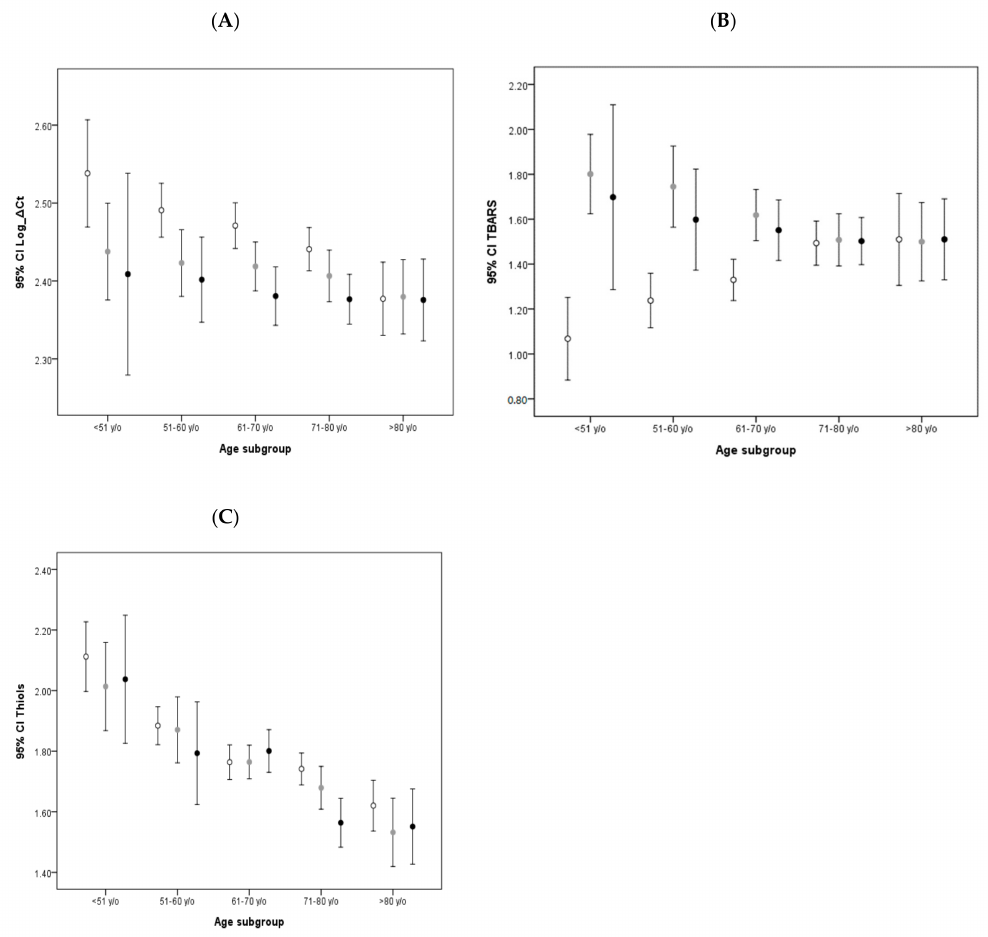
Figure 3. Age-stratified comparison of influences of various total equivalent dopamine doses (TEDDs) on oxidative stress markers and mtDNA copy number: Error bar plots show levels of average Log Ct copy number ( A ), TBARS ( B ), and thiols ( C ) in di ff erent TEDD subgroups of PD patients and non-PD controls. ( • in ( A – C ) represents higher dopamine dose group of PD patients; • in ( A – C ) represents lower dopamine dose group of PD patients; in ( A – C ) represents dopamine-naive group of non-PD (cid:35)